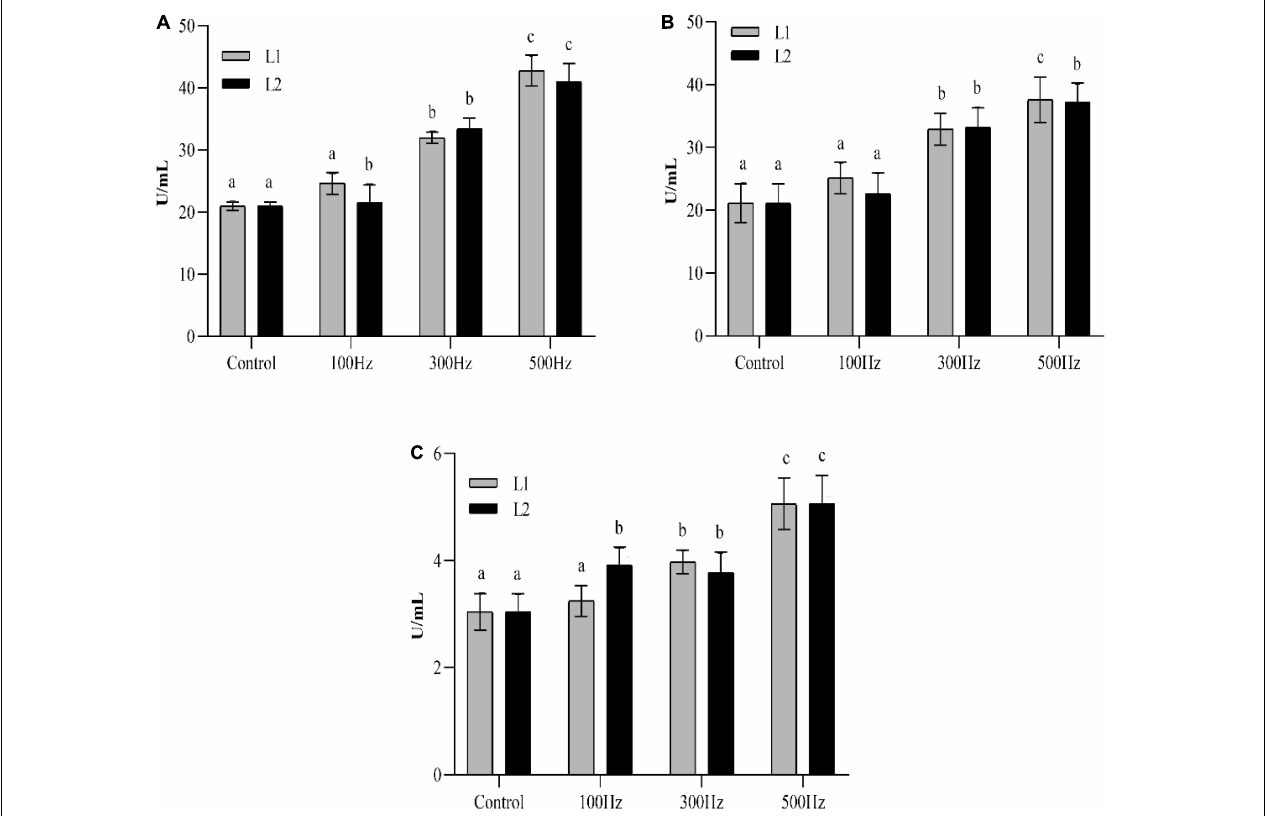
FIGURE 2 | Changes in enzyme activities in the hemolymph of sea slugs exposed to different frequencies of low-frequency noise. SOD (A) superoxide dismutase; CAT (B) catalase; MDA (C) malondialdehyde. Data are shown as the mean ± SE of n = 9. Lowercases indicate statistically significant differences between experimental groups at the same time point ( P <